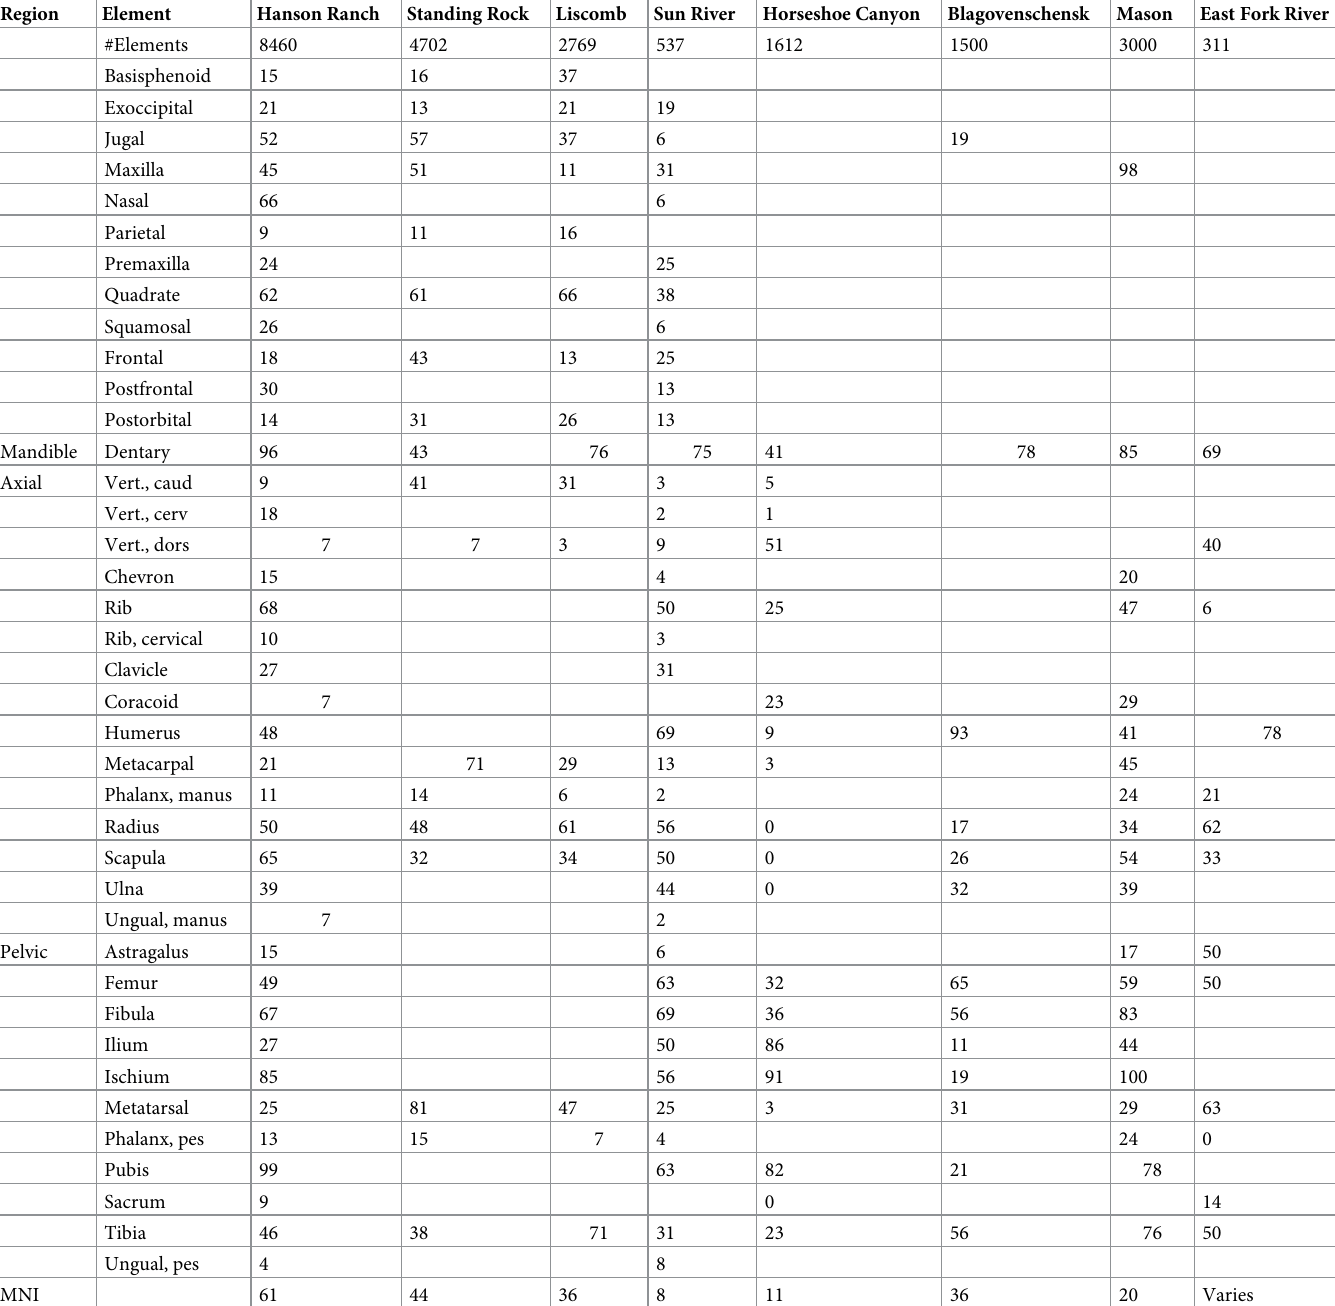
Table 5. Element comparisons among different bonebeds. All except East Fork River are dinosaurs. Percent of total possible elements based on each bonebed MNI are listed. Percent of recovered extant bones are listed for East Fork River. Data for the other sites were derived from the following references: Standing Rock [9], Sun River [51], Blagovenschensk[44], Liscomb[6], Horseshoe Canyon [3], Mason Dinosaur Quarry [10], East Fork River [90]. Abbreviations: MNI, minimum number of individuals; Vert.,